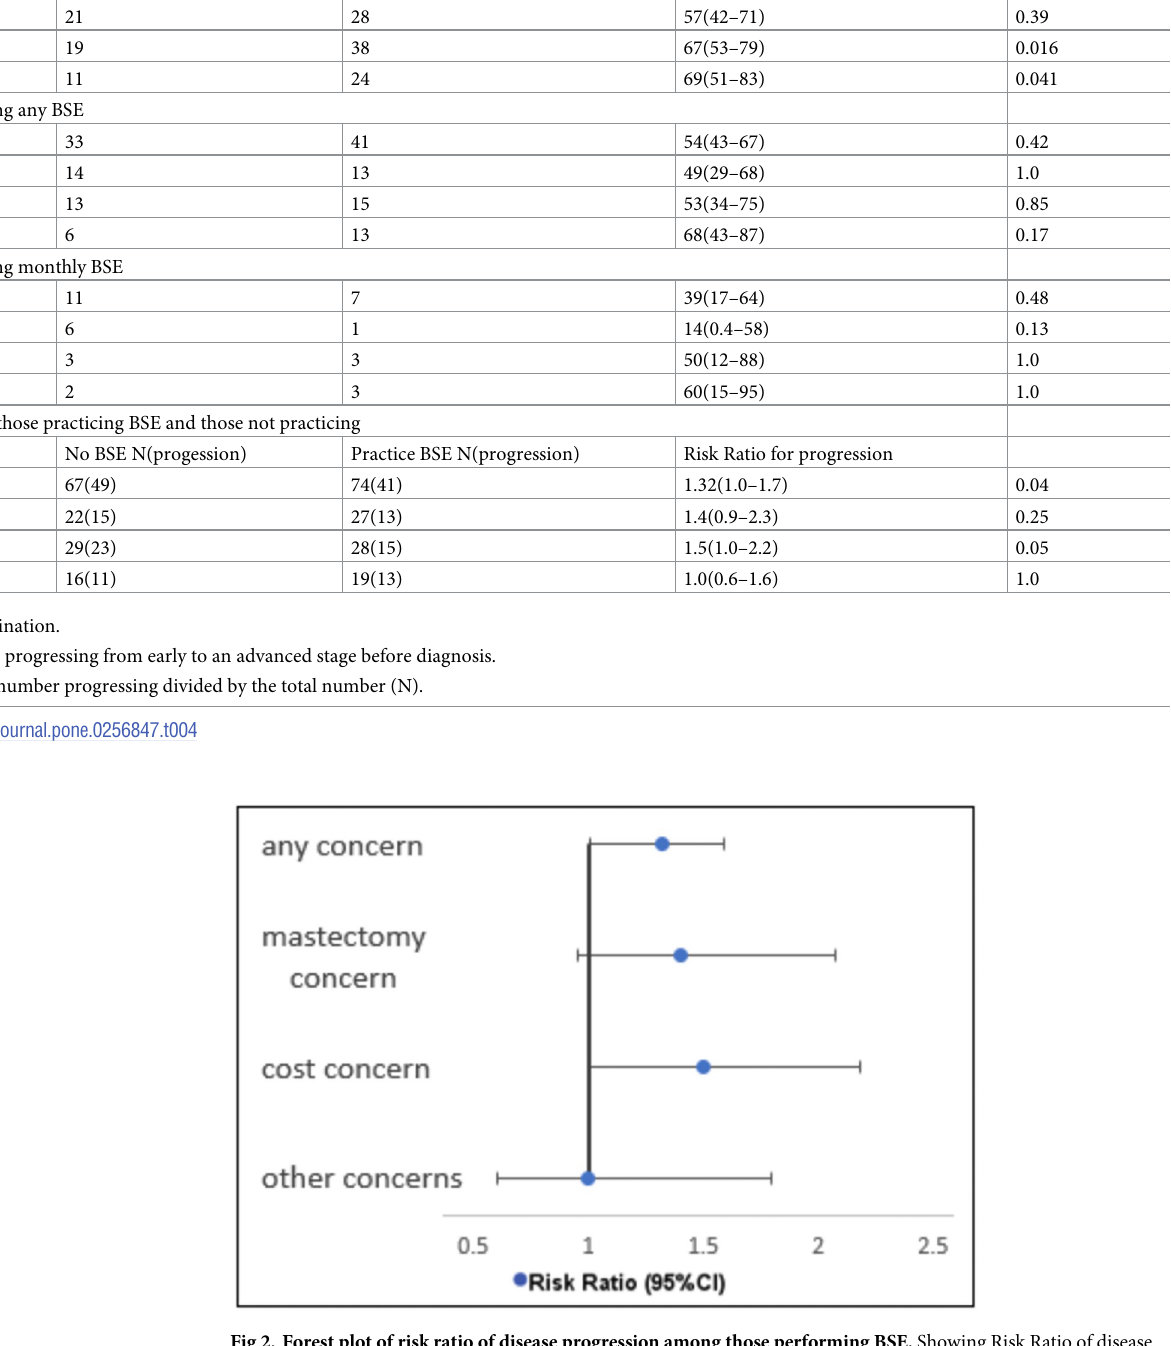
Fig 2. Forest plot of risk ratio of disease progression among those performing BSE. Showing Risk Ratio of disease progression among patients not performing Breast Self-Examination compared to those performing Breast Self-